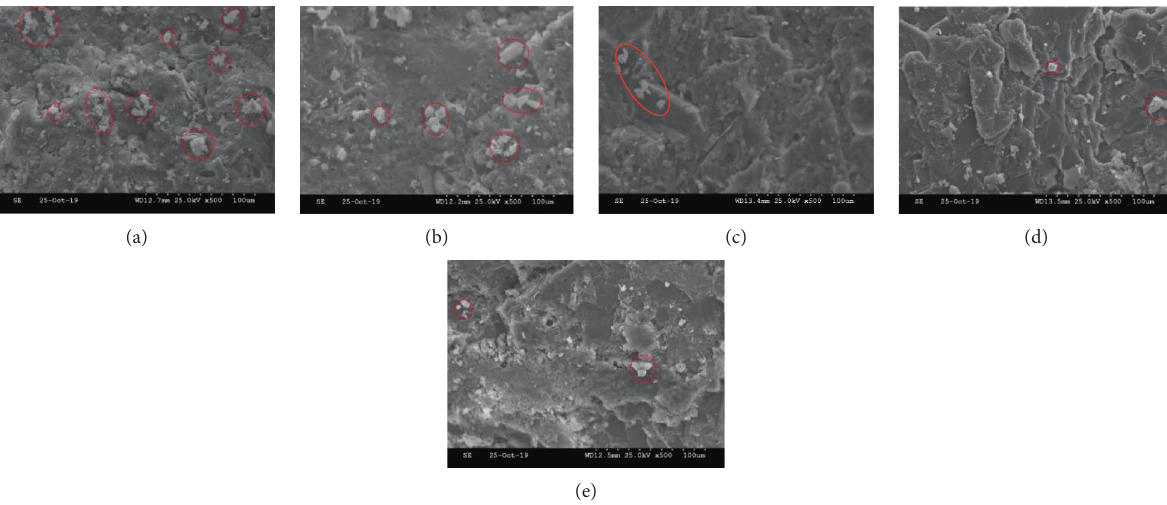
Figure 10: Electron microscopy scans of specimens at 300 days of corrosion: (a) immersion 0.8% (0cm), (b) immersion 3% (0cm), (c) immersion 0.27% (0cm), (d) dry-wet 0.8% (2cm), and (e) immersion 3%